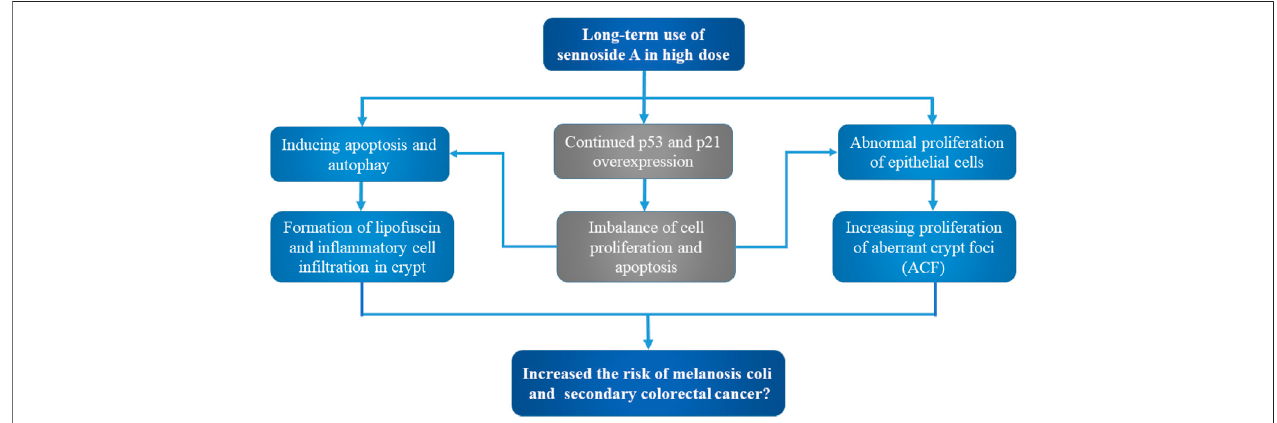
FIGURE 3 | Potential carcinogenic toxicity and mechanism of sennoside A. Although still uncertain, SA may cause melanosis coli and subsequent colon cancer. The potential toxic mechanisms involve the aberrant cell proliferation and apoptosis, as well as in fl ammatory cell in fi ltration and aberrant crypt